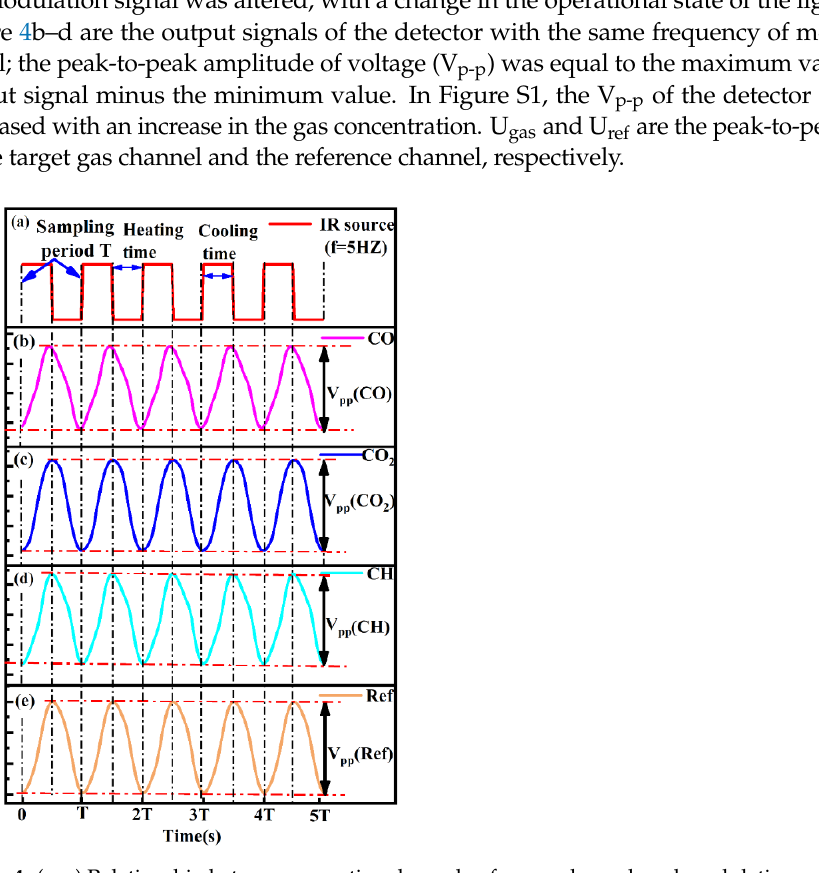
Figure 4. ( a – e ) Relationship between gas active channel, reference channel, and modulating pulse